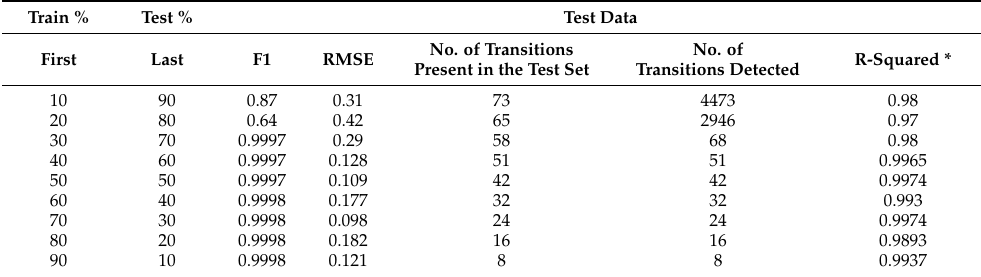
Table 9. Forecasting efficacy of the RNN model for different training and testing partitions. Train % Test %